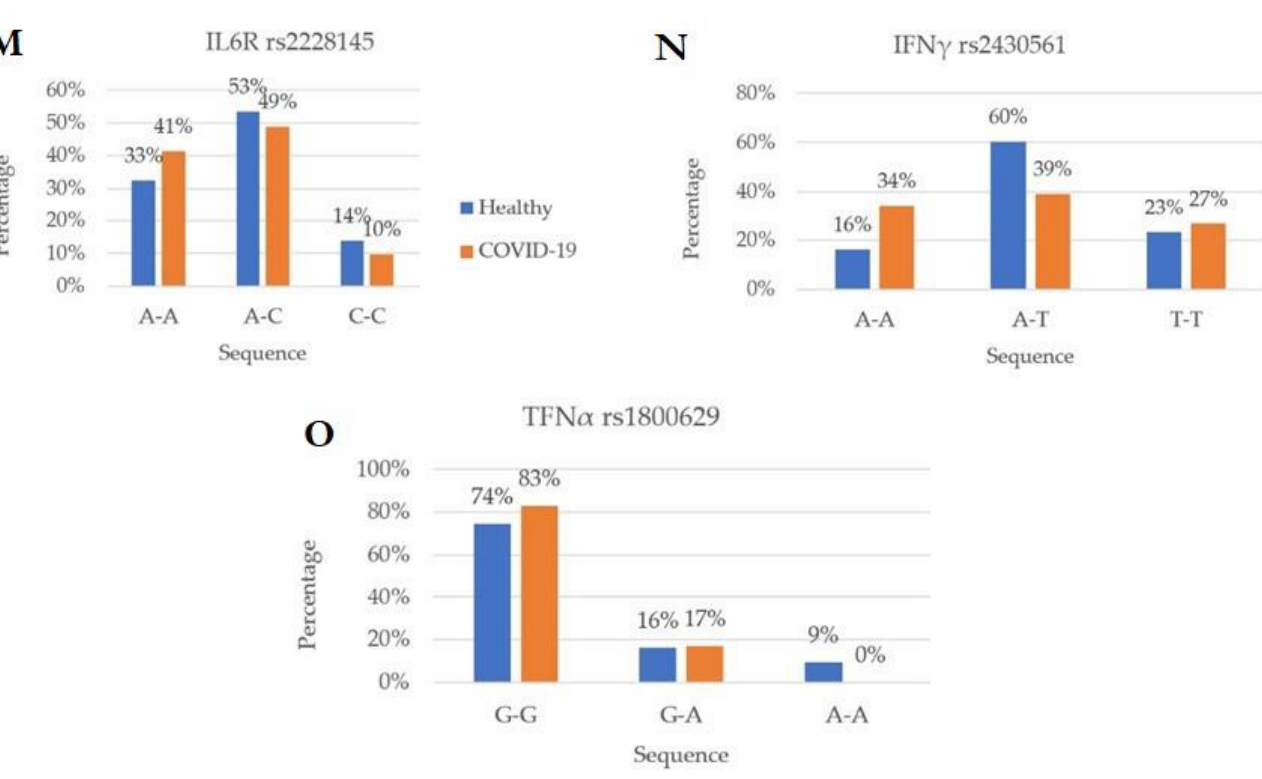
Figure 1. Genotype distribution of 15 SNPs among the healthy (blue) and affected (Orange) subjects analyzed. ( A ) SNPs and ACE: the analysis indicates that the I/I genotype is suggestive of higher protection to COVID-19 infection (19% vs 10%), while the expression of I/D may represent a higher susceptibility to the infection; a higher frequency of the I/D genotype (48% vs. 42%) and the D allele (>43% overall) was reported in COVID-19 patients than controls (95% CI, p < 0.05) [22]. ( B ) SNP in the Serpina3 (AACT) gene seems to be tissue-specific and influences protease targeting considered to play a key role in neuro-degenerative disorders. The gene is involved in expressing the protein during acute and chronic inflammation. The Serpina3 seems to be significantly associated with critical illness in COVID-19. The analysis indicates that the G/G genotype is suggestive of higher protection to COVID-19 infection (21%vs 15%; 95% CI, p < 0.05) [23 – 26]. ( C ) Circulating CRP concentration reflects systemic inflammation. Some polymorphisms have been linked with high expression during inflammatory conditions such as in COVID-19; the outcomes indicated that the G/G genotype is suggestive of higher protection to COVID-19 infection (46% vs. 40%), while the expression of G/A (normal genotype) (95% CI, 95% CI, p < 0.05) and A/A (7% vs. 2%) (gene down-expression) may represent a sort of susceptibility to the infection; in allelic comparison, the G allele was strongly associated with COVID-19 infection (95% CI, 95% CI, p < 0.05) [27 – 29]. ( D – F ) VDR gene polymorphisms might play critical roles in the vulnerability to infection and severity of COVID-19. The allele frequencies for the SNPs of the VDR gene ( FokI, BsmI, and TaqI ) were compared between infected cases and controls. The analysis regarding VDR Fok1 indicates that the T/C genotype might be significantly associated with COVID-19 infection (56% vs. 44%; 95% CI, p < 0.05), while the expression of T/T (40% vs. 29%) indicated a significant protection against the infection (95% CI, p < 0.05); Taq1 , the A/G genotype, was significantly associated with COVID-19 infection (59% vs. 47%; 95% CI, p < 0.05), while the expression of G/G (37% vs. 27%) indicated a significant protection against the infection (95% CI, p < 0.05) [49,50]. ( G , H ) the carriers with IL1β c -81 with C/T genotype has been associated with increased IL- 1β production and grade of inflammation. The carriers with 511 C/T genotypes were also seen with higher incidence of COVID-19 infection (95% CI, p > 0.05) [39 – 41]. ( I , J ) The human IL-6 572 gene is involved in anti-E production, with the allele G as the major risk allele. This is evidence that there is a clear genetic influence on plasma levels of fibrinogen and CRP. However, the data did not indicate a clear involvement in COVID-19 disease. Conversely, IL-6 174 rs1800795 polymorphism has been shown to be highly related to inflammatory and neuropathic patterns in several diseases such as DM2, atherosclerosis, CVD, and COVID-19. The G/G genotype is suggestive of IL-6 gene overexpression. There were significant differences between the two